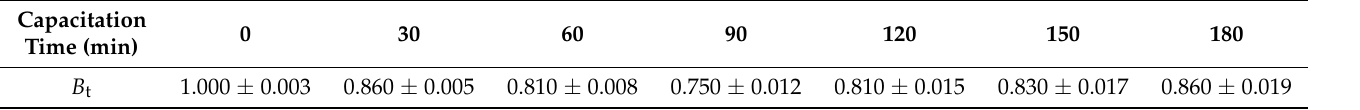
Table 1. The relative concentration B t , obtained for the individual capacitation times, mean ± stand- ard error of the mean ( n = 3). Capacitation Time (min)